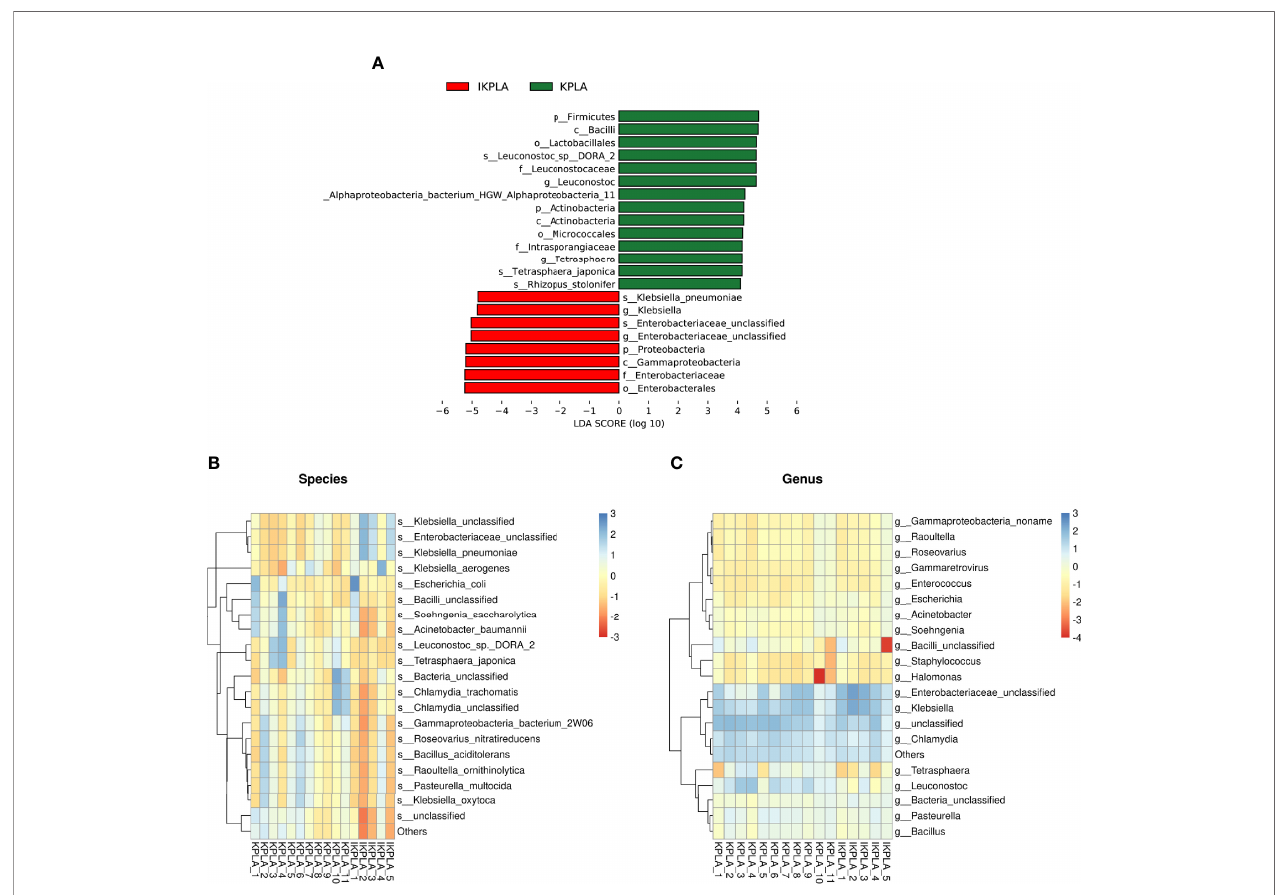
FIGURE 3 | Linear discriminant-analysis effect-size (LEfSe) analyses to identify the taxonomic features most likely to explain the differences between the groups. A total of 22 taxa were identi fi ed as signi fi cantly different between KPLA and IKPLA by LEfSe (A) . Clustering correlation heatmaps based on the top 20 genus or species showed that there were differences in the species level (B) but no difference in the genus level (C)